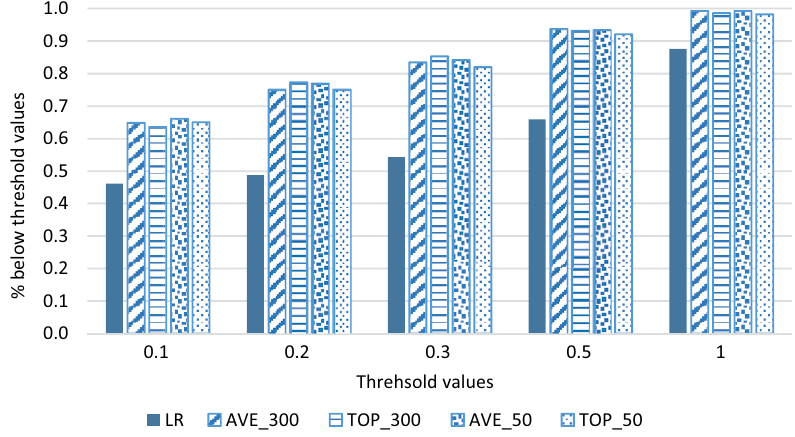
Figure 9. Committees of 50 nets and 300 nets compared to Linear Regression using error threshold